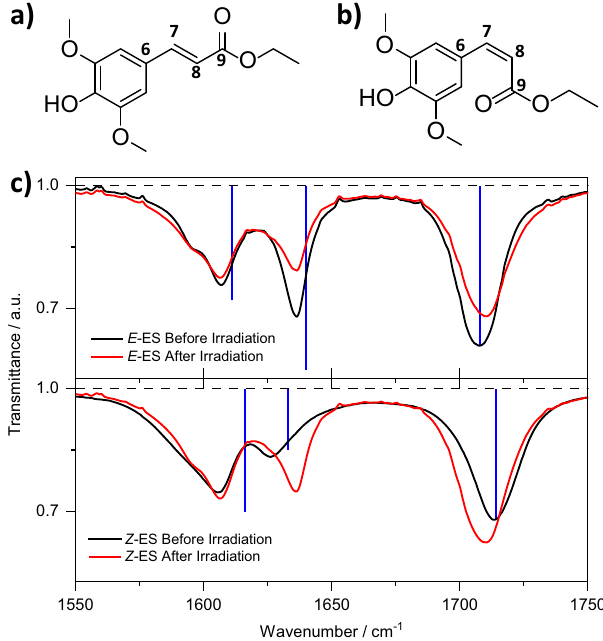
Fig. 1 Structure and vibrational spectra of ethyl sinapate (ES) isomers. a E -ES molecular structure, and b Z -ES molecular structure. c Steady-state vibrational spectra of 20 mM solution of E -ES (top panel) and Z -ES (bottom panel) in acetonitrile before (black) and after (red) 6 h irradiation with a solar simulator with irradiance equivalent to 1 sun (1000 W/m 2 ). The overlaid vertical blue lines in c correspond to the calculated frequencies at B3LYP/6-311 ++ G** level of theory in implicit acetonitrile; the lines ’ wavenumbers have been scaled with factors of 0.9879 for E -ES and 0.9908 for Z -ES as further discussed in the supplementary information Note